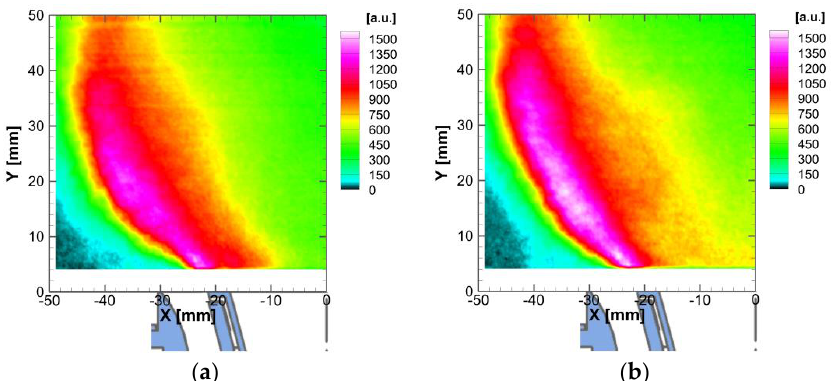
Figure 18. OH-LIF distribution under cruise conditions: ( a ) case P and ( b ) case M. (Illustration of the burner exit section is superimposed beneath the horizontal axis).